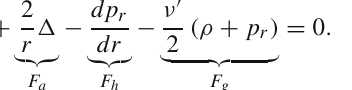
ting these graphs, the numerical values for the constant parameters are α = 0 . 030390 / km 2 , β = 0 . 000075 / km 4 , C = 0 . 9985 and D = 0 .